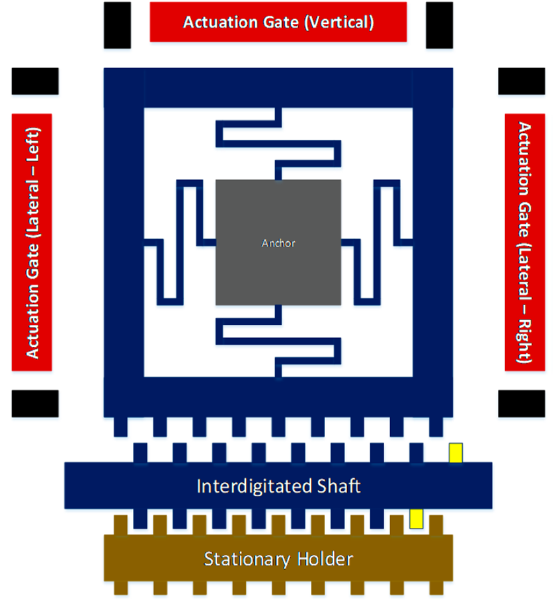
Figure 5. Top view of multiple-degrees-of-freedom electrostatic actuator. Adapted from [70].